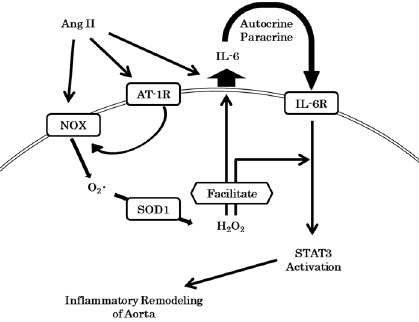
Figure 7. The cytosolic H 2 O 2 produced by SOD1 facilitated IL-6 synthesis in VSMCs and its secre- tion from them, which had been induced by AngII. H 2 O 2 facilitated the activation of STAT3 by IL- 6. These mechanisms were responsible for the inflammatory remodeling of aortas. AT-1R: